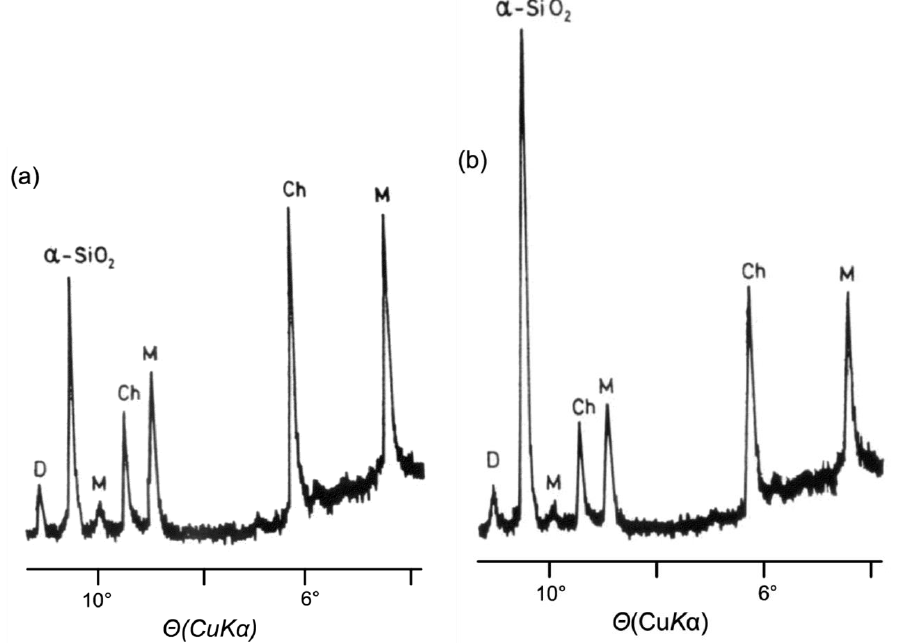
Figure 1. Parts of X-ray diffraction patterns of industrial dust; determination of the fraction of quartz, α-SiO 2 ( X ) by the doping method (i): ( a ) original sample, ( b ) the sample doped with X a = 0.286. The fraction of quartz in the original sample: X = 0.200(10). Other phases: Ch, chlorites; D, dolomite; M, micas. Radiation Cu K α [10].